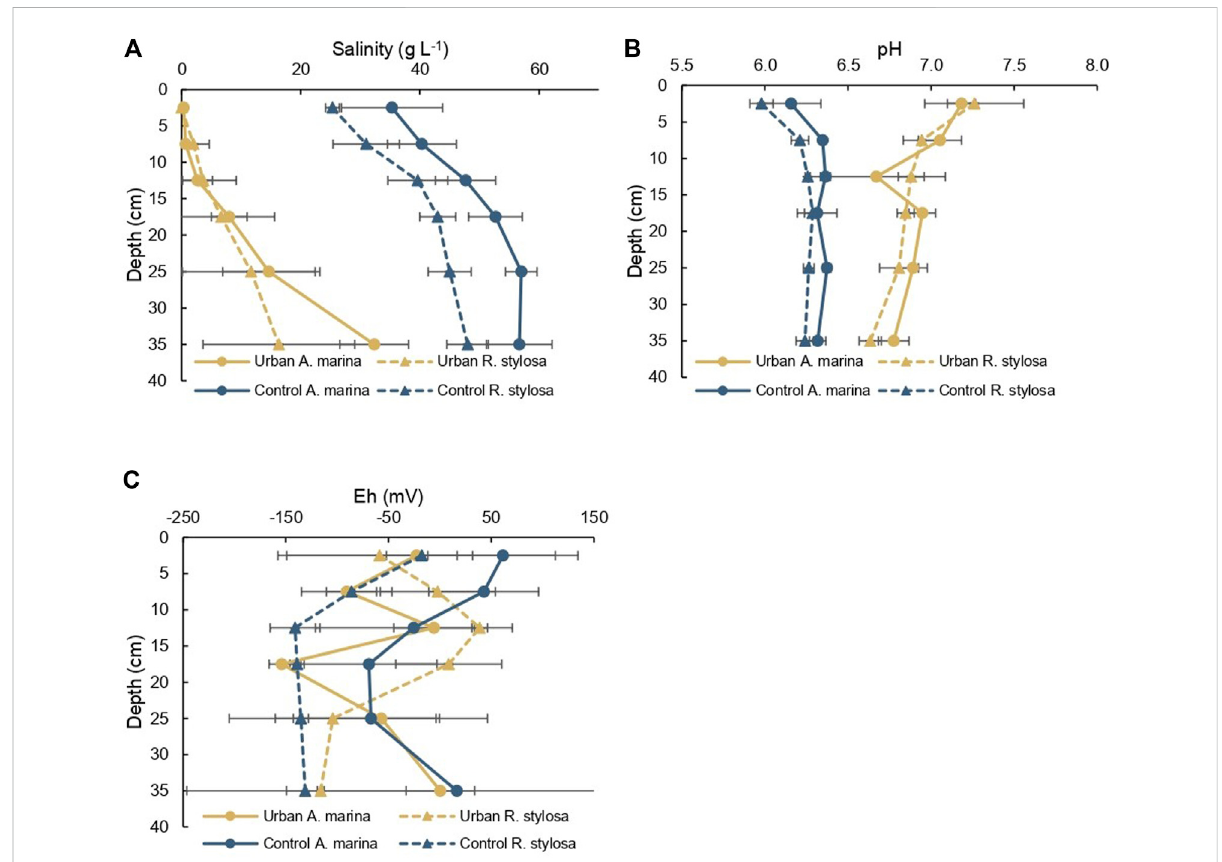
FIGURE 2 Mean values for (A) salinity in g L − 1 , (B) pH, and (C) Eh in mV along the soil cores of the urban and control sites under both mangrove species ( A. marina and R. stylosa ) with error bars corresponding to standard deviation of